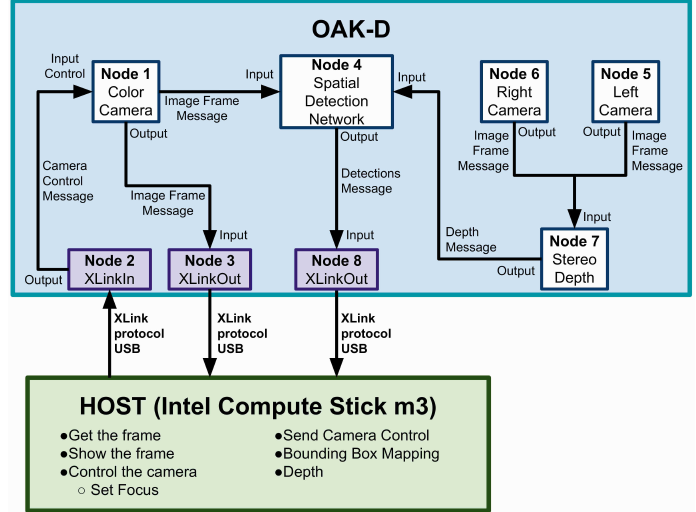
Figure 2. General diagram of the internal configuration of the OAK-D camera to obtain colour camera images, an object of interest, and their spatial position with respect to the camera.